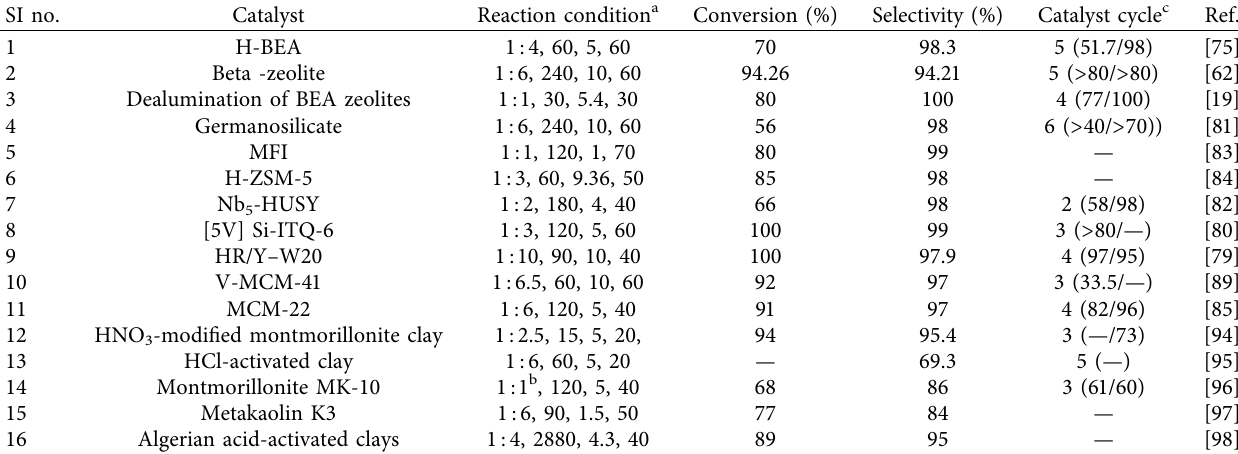
Table 2: Zeolite and clay catalyst for solketal